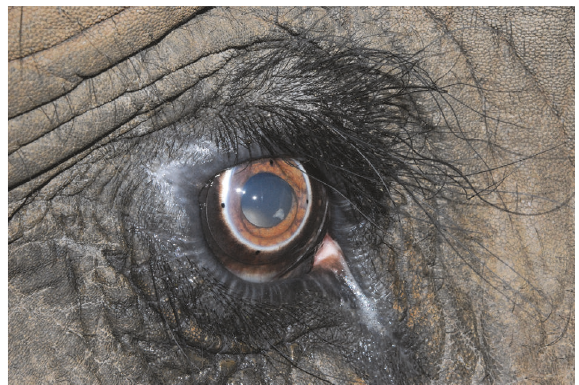
Figure 13: A corrective contact lens (+ 9.00 diopters) has been placed in the elephant’s right eye in an attempt to correct the marked hyperopia due to his being left aphakic (Acrivet, Veterinary Division of S&V Technologies AG, Hennigsdorf, Germany). Note the smaller circular area within the center of the lens (this is most readily visible along the ventromedial pupil extending from approximately 2:30 to 9:00 o’clock) that represents the corrective portion of the lens. The four black dots at the 12, 3, 6, and 9 o’clock edges of the corrective contact lens are to make it easier to visualize during subsequent